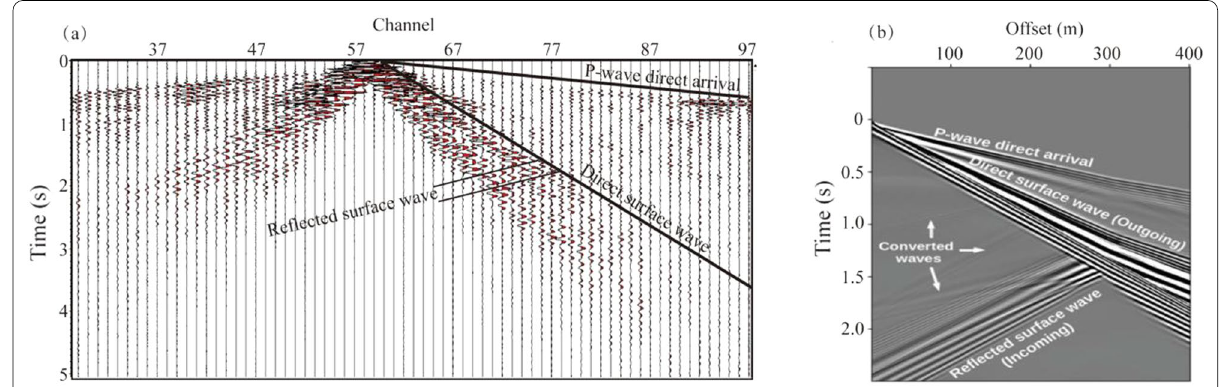
Fig. 8 Reflected surface wave signal a Original single shot record (21417). b Schematic diagram of the reflected surface wave Hyslop et al.